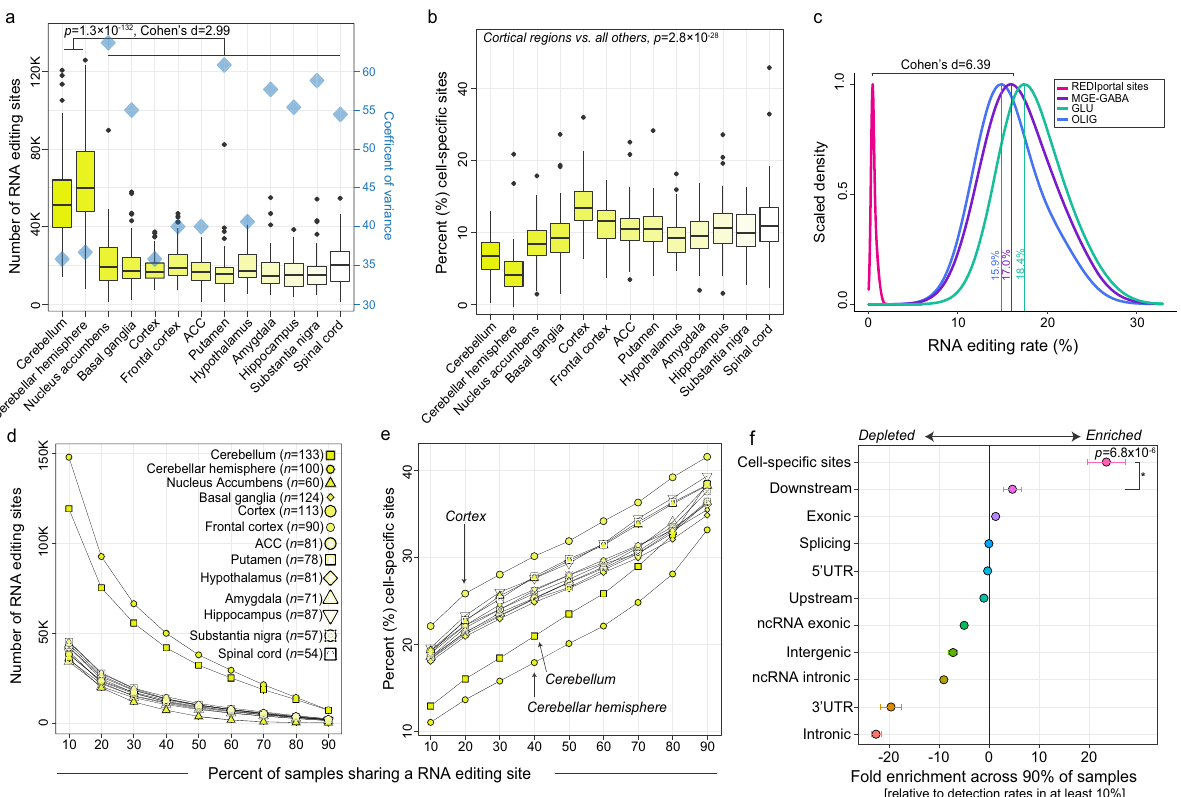
Fig. 6 Annotation of cell type-associated sites in bulk tissue. a Total number of selective editing sites (y-axis) reported along with the coef fi cient of variance (blue diamonds) for each GTEx brain region to describe intraregional variation amongst donors. b The percentage of cell type-associated editing sites out of the total number of editing sites per donor (y-axis). Box plots show the medians (horizontal lines), upper and lower quartiles (inner box edges), and 1.5 × the interquartile range (whiskers). c Density distribution plots of cell type-associated editing levels relative to all other detected sites in the REDIportal database without cellular annotations. For all tests, a two-sided regression analysis was used to compute signi fi cance. No adjustments were made for multiple comparisons. d A sliding threshold was used to identify sites shared amongst a given percentage of samples per region (x-axis). e Following each threshold, the fraction of cell type-associated editing sites were computed, further highlighting cortical enrichment. f Fold-enrichment analysis (sites detected in 90% of samples relative to sites detected in 10% of samples) informs cell type-associated sites are detected across most independent biological replicates (* indicates p = 6.8 × 10 − 6 ). Standard error bars re fl ect brain region level variability. A two-sided regression analysis was used to compute signi fi cance. No adjustments were made for multiple